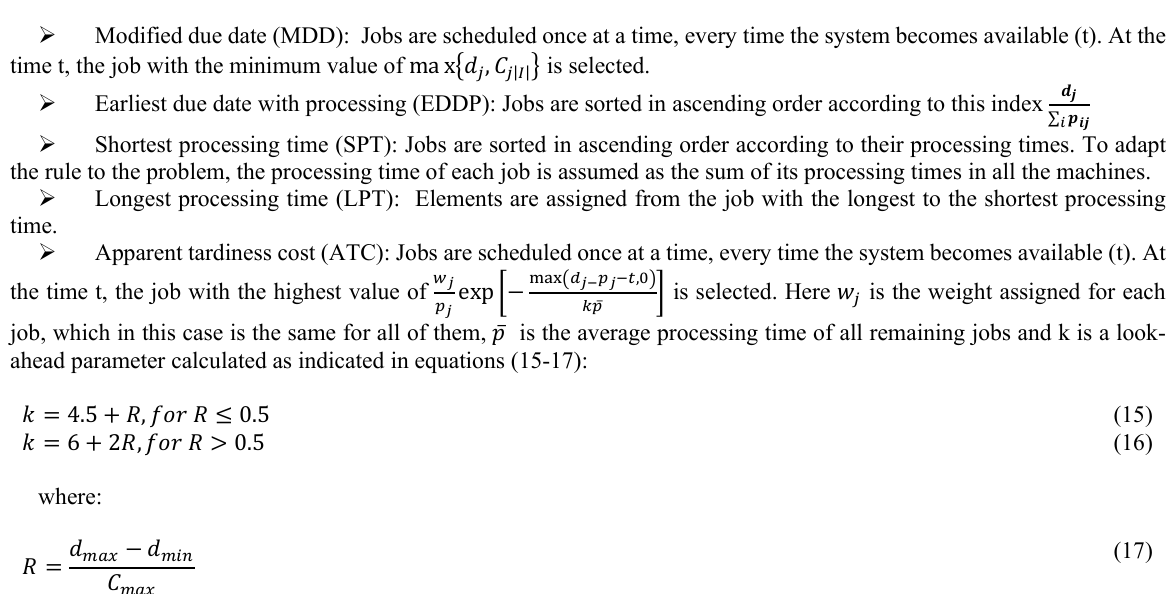
Fig. 2 Chromosome representation. Made by the